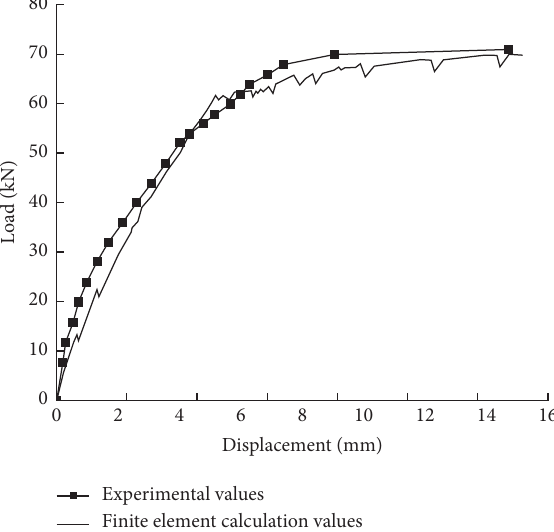
Figure 14: Load-deflection curve of test beam BM6-2.